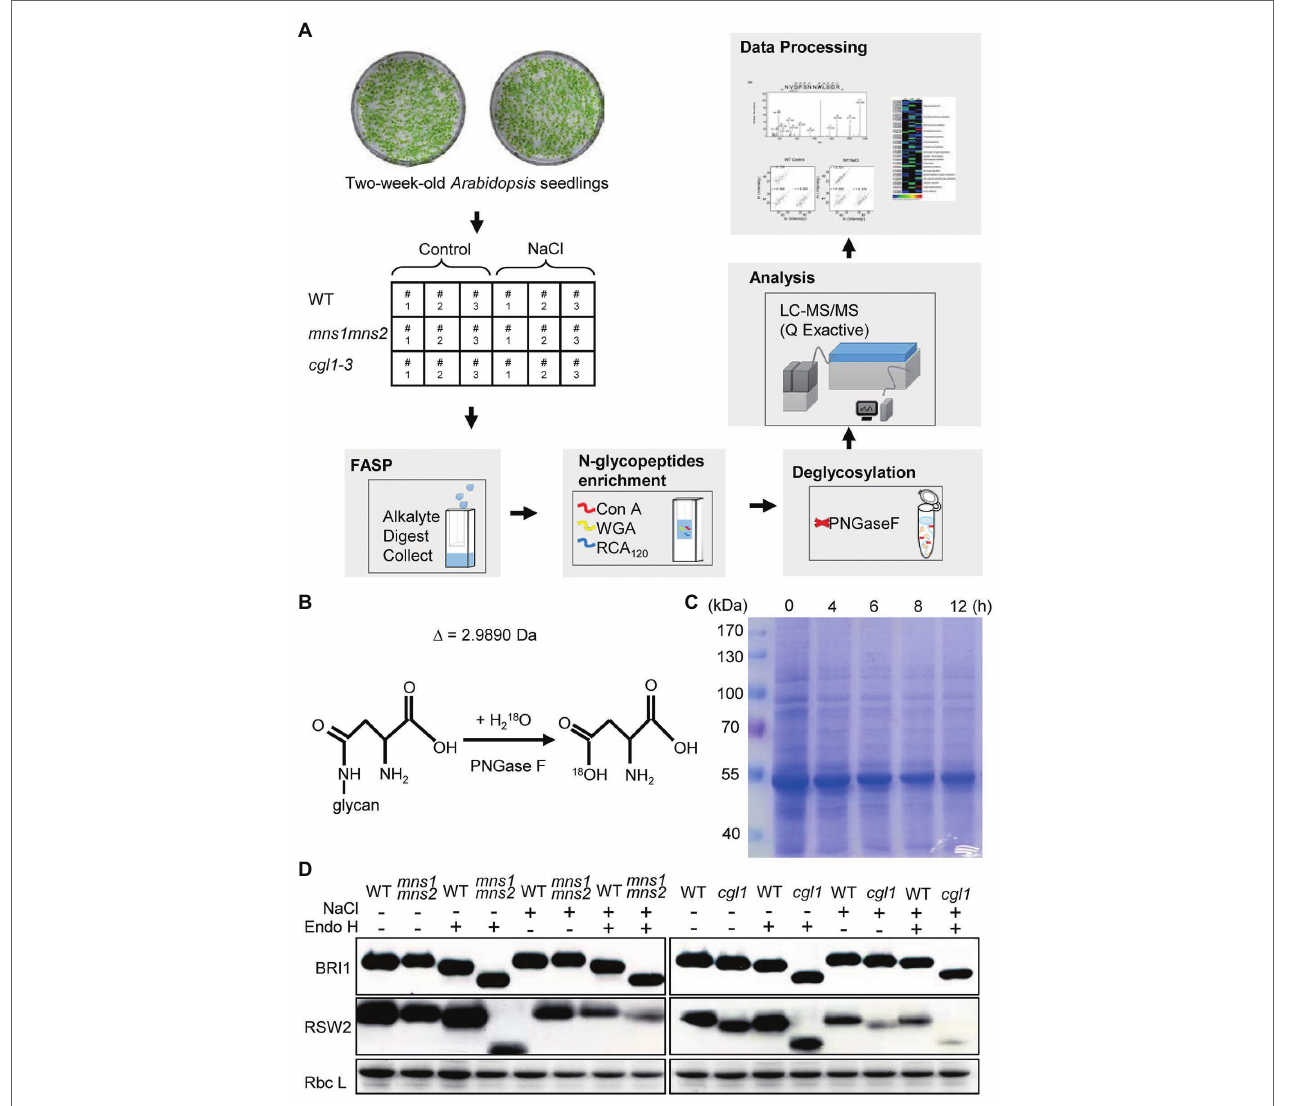
FIGURE 1 | Schematic workflow of the experimental procedure. (A) A summary of the experimental design. Two-week-old seedlings were treated without (control) or 200 mM NaCl treatment (NaCl) for 6 h. Then, the total protein was extracted and digested into peptides using the filter aided sample preparation (FASP) method. N-glycopeptides were enriched by multiple mixed lectins and resolved by liquid chromatography coupled mass spectrometry (LC-MS/MS) after PNGase F digestion. The raw MS files were processed by MaxQuant. Three biological repeats were conducted. (B) Illustration of de-glycosylation of N-glycopeptides in H 218 O by PNGase F. In the presence of H 218 O, the conversion from Asn to Asp had a 2.9890 Da increase in molecular weight. (C) Detection of total protein abundance after salt treatment for different lengths of time. Two-week-old wild-type (WT) seedlings were treated in 200 mM NaCl for 0, 4, 6, 8, or 12 h. Total proteins were extracted and separated by 10% sodium dodecyl sulfate polyacrylamide gel electrophoresis. Gels were stained by Coomassie Brilliant Blue R-250 (CBB). (D) N-glycan structure analyses by Endo H digestion. Total proteins were extracted from control and salt-treated seedlings. After Endo H digestion, the proteins were separated on 10% SDS-PAGE and used anti-BRI1 and anti-RSW2 antibodies to analyze protein-associated N-glycan. CBB staining was shown as a loading